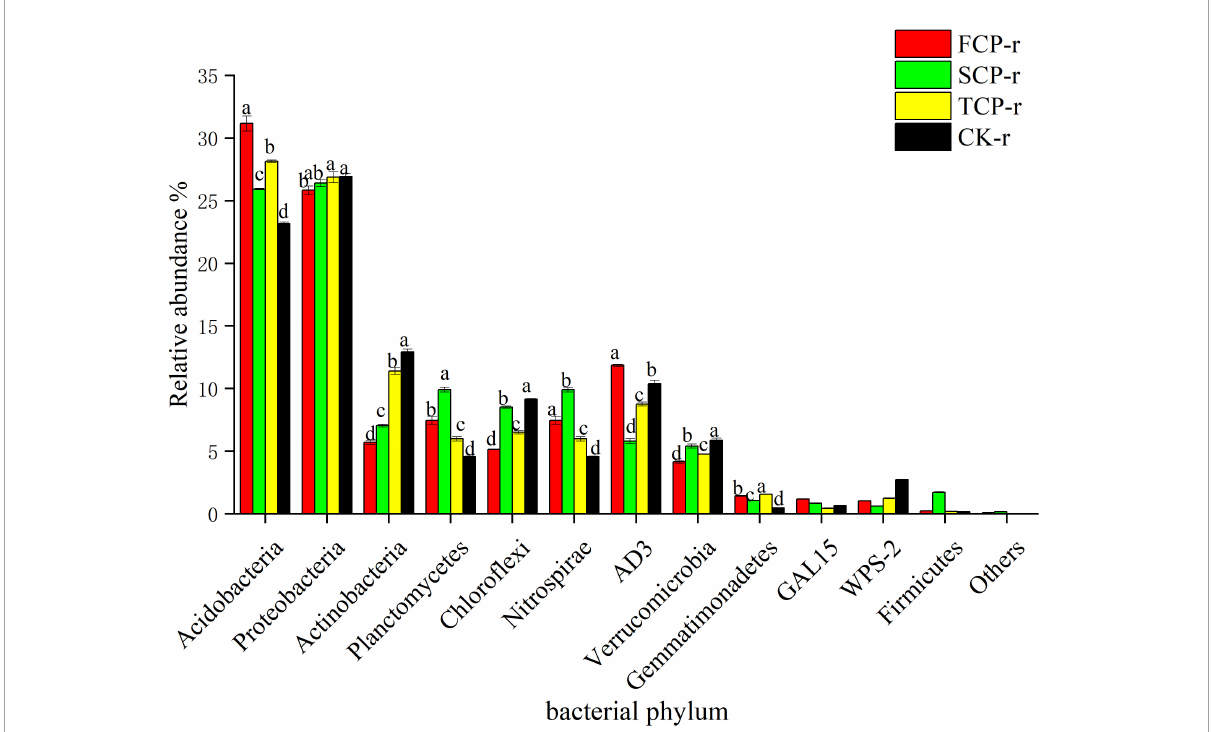
FIGURE2 Relative abundance of predominant bacterial community in successive generations within rhizosphere soil at the phyla level. Other stands for undefined categories. Value show means ± standard error ( n = 3). Different lowercase letters show significant differences. CK, Nanmu seedings; FCP, first-generation seedings; SCP, second-generation seedings; TCP, third-generation seedings. r, rhizosphere